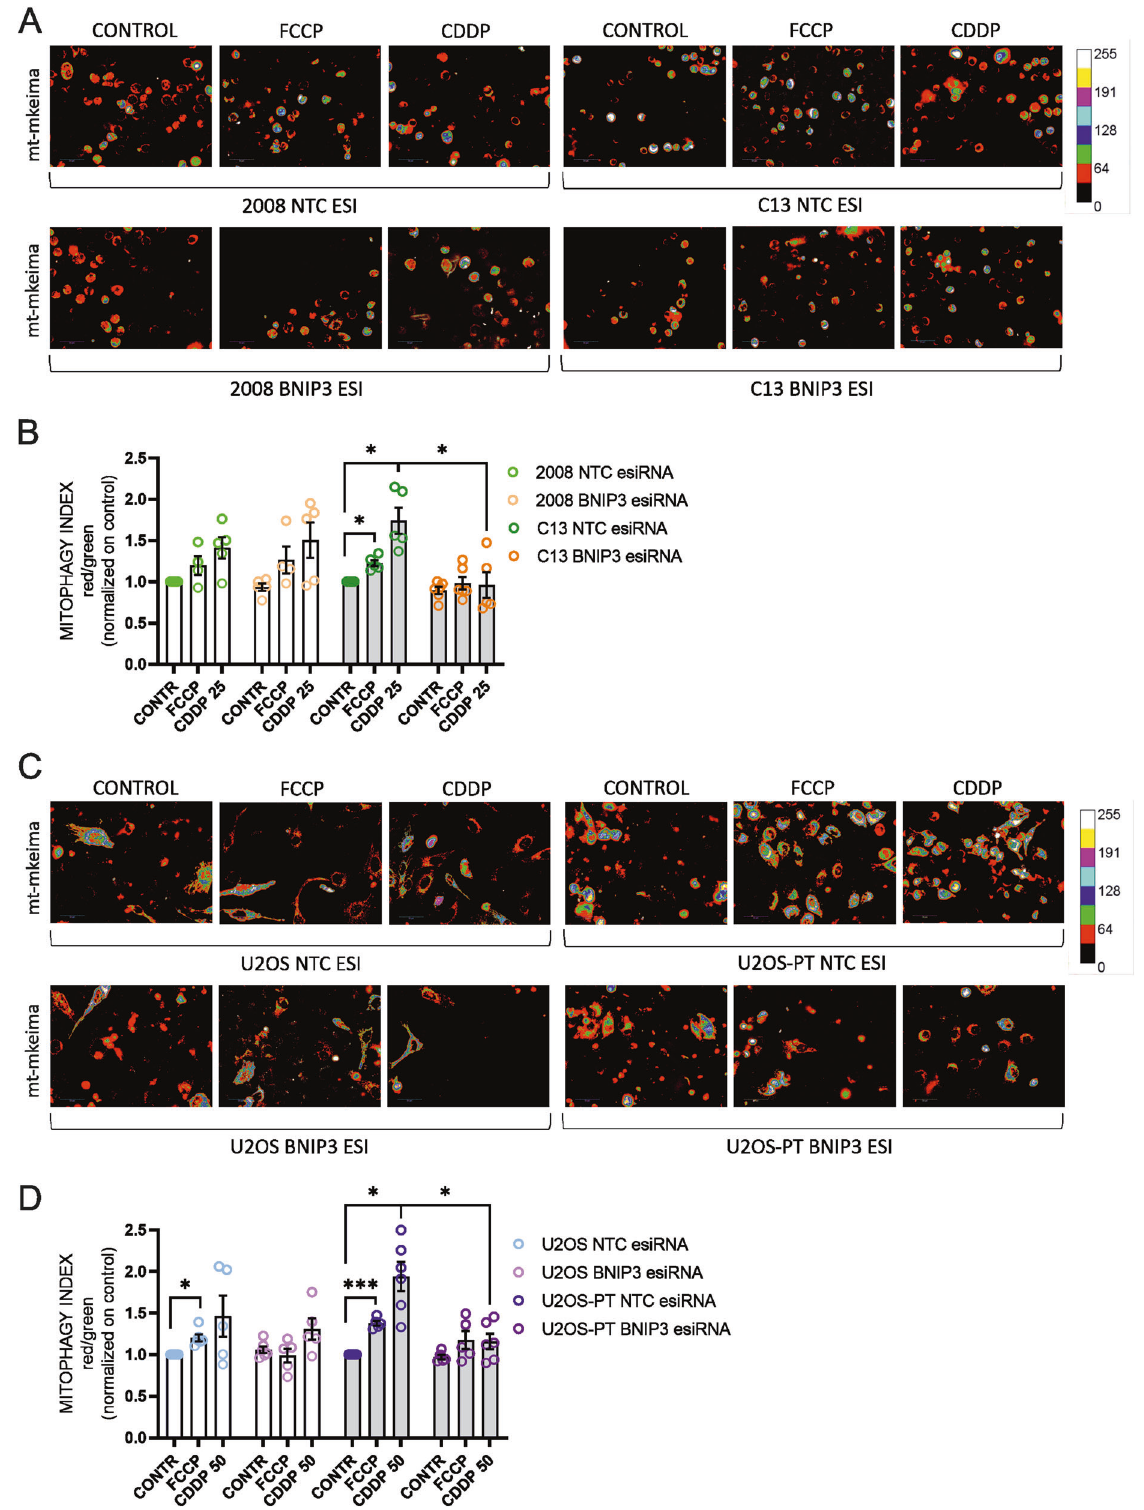
Fig. 5 BNIP3 silencing suppresses mitophagy. Effect of 24 h of CDDP (25 – 50 µM) and of overnight of FCCP (10 µM) on mitophagy of 2008- C13 ( A ) and U2OS-U2OS-PT ( C ) transfected with non-targeting control (NTC, scramble) esiRNA or with an esiRNA targeting BNIP3 (esiBNIP3). The respective Mitophagy Index and quanti fi cation is reported in ( B ) and ( D ). Data are the mean ± SEM of 5 – 6 different experiments. * p < 0.05; calculated by a two-tailed unpaired t-test comparing esiRNA targeting BNIP3 (esiBNIP3) cells vs non-targeting control (NTC, scramble) esiRNA cells; * p < 0.05, *** p < 0.001, calculated by a two-tailed unpaired t -test comparing treated cells vs untreated cells.